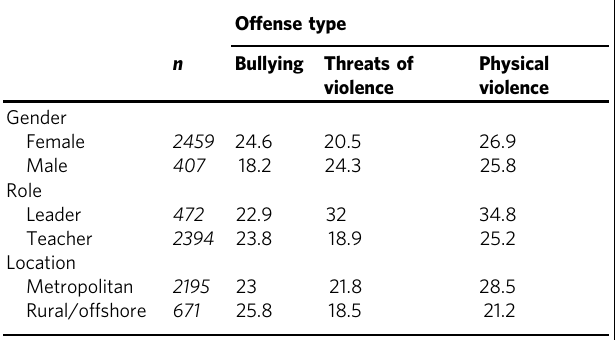
Table 3 Self-reported experience of offensive behaviors — primary-school teaching leaders.